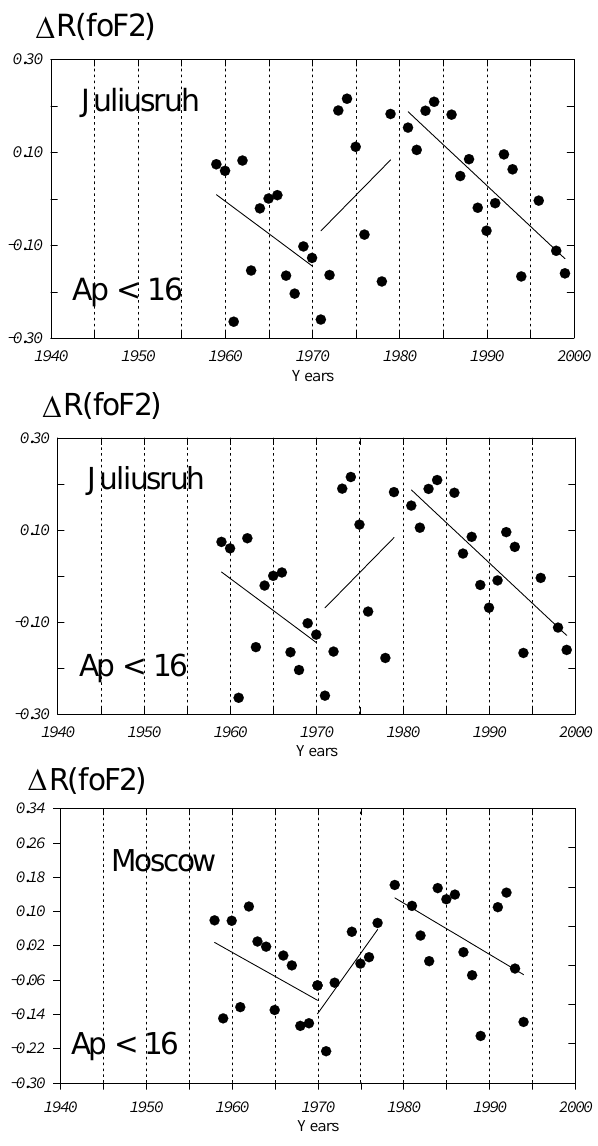
Fig. 8. Time behavior of 1R ( fo F2) for Gorky, Juliusruh, and Moscow.